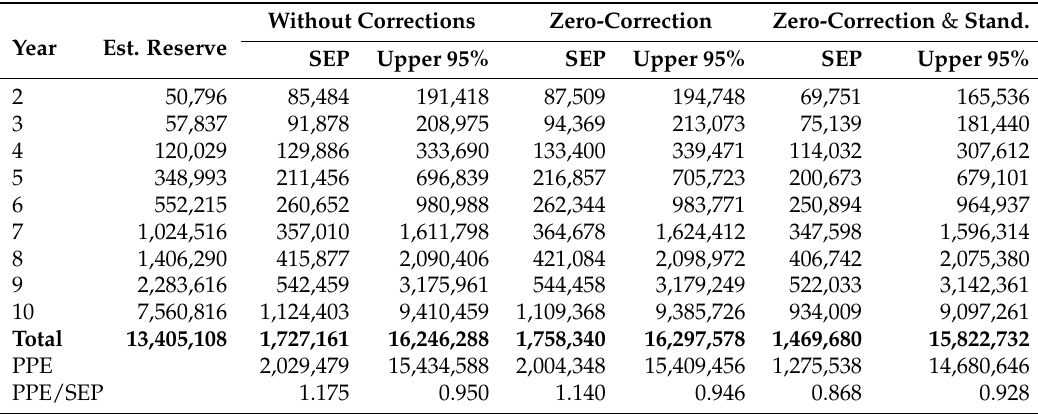
Table 4. Over-dispersed Poisson model with Anscombe